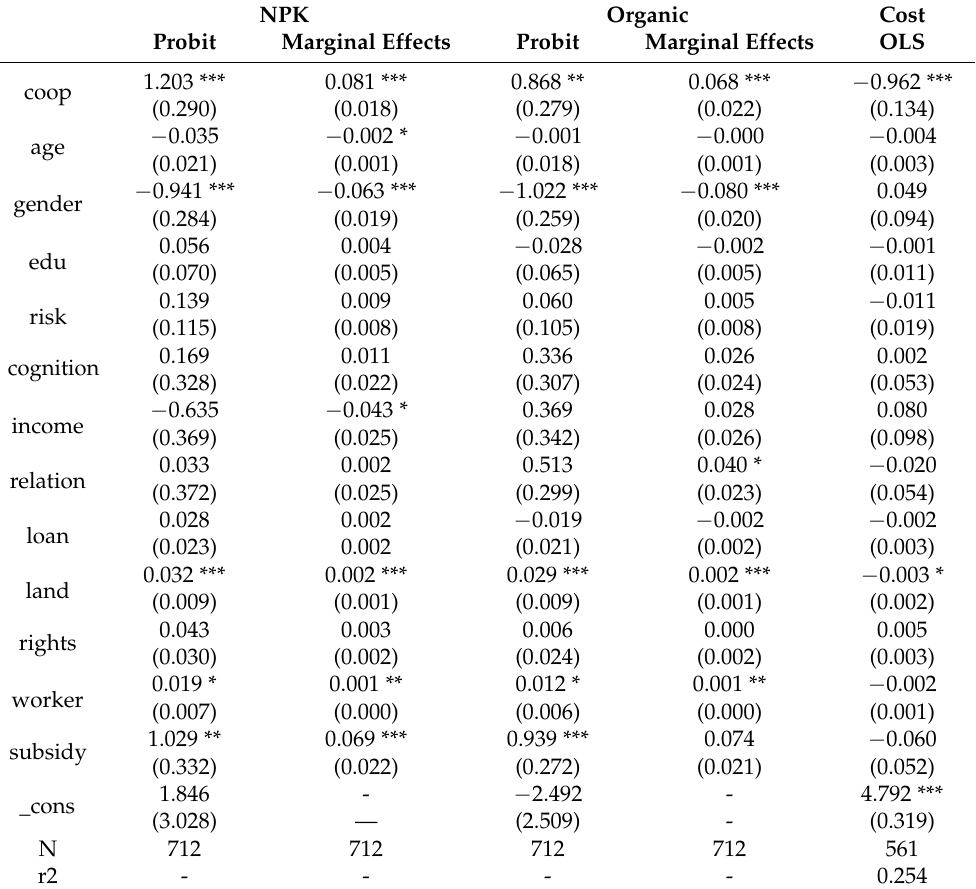
Table 2. Baseline regression results for whether joining a cooperative reduces fertilizer application by smallholder farmers. NPK Organic Marginal Effects Marginal